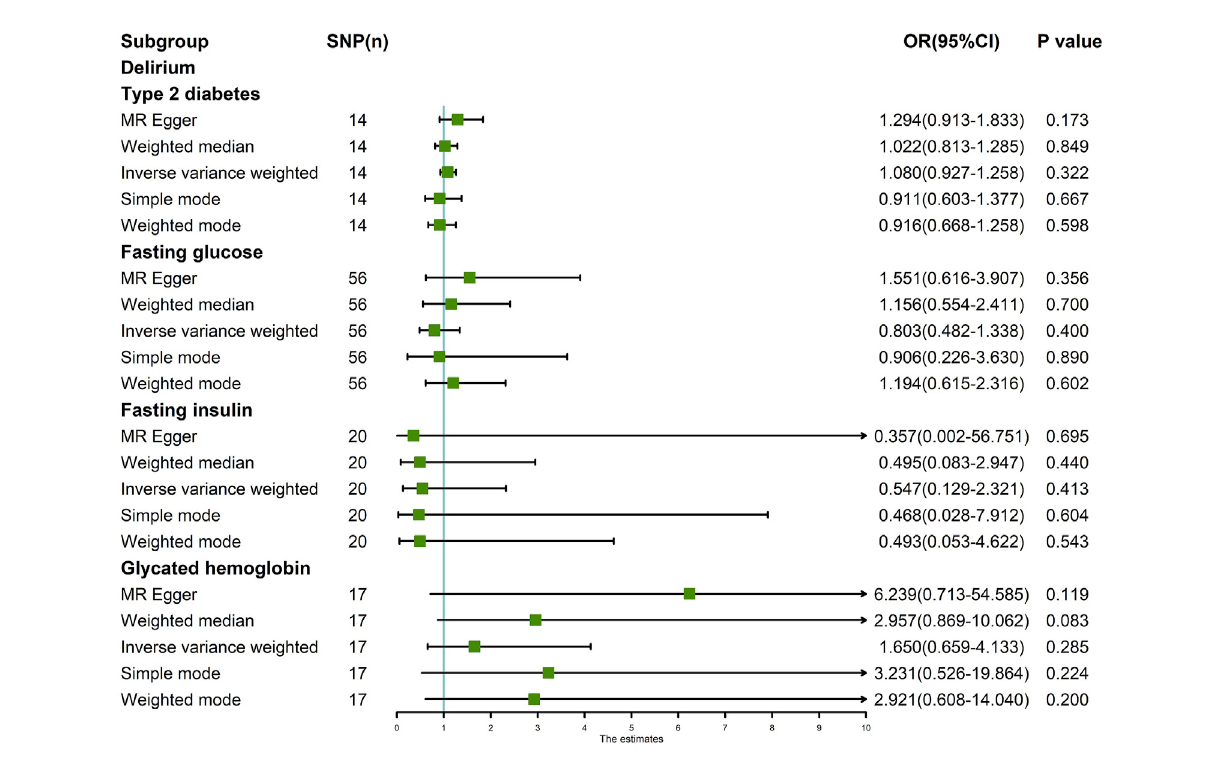
FIGURE 1 MR analysis results of the four exposures (T2D, FG, FI, and HbA1c) and outcome